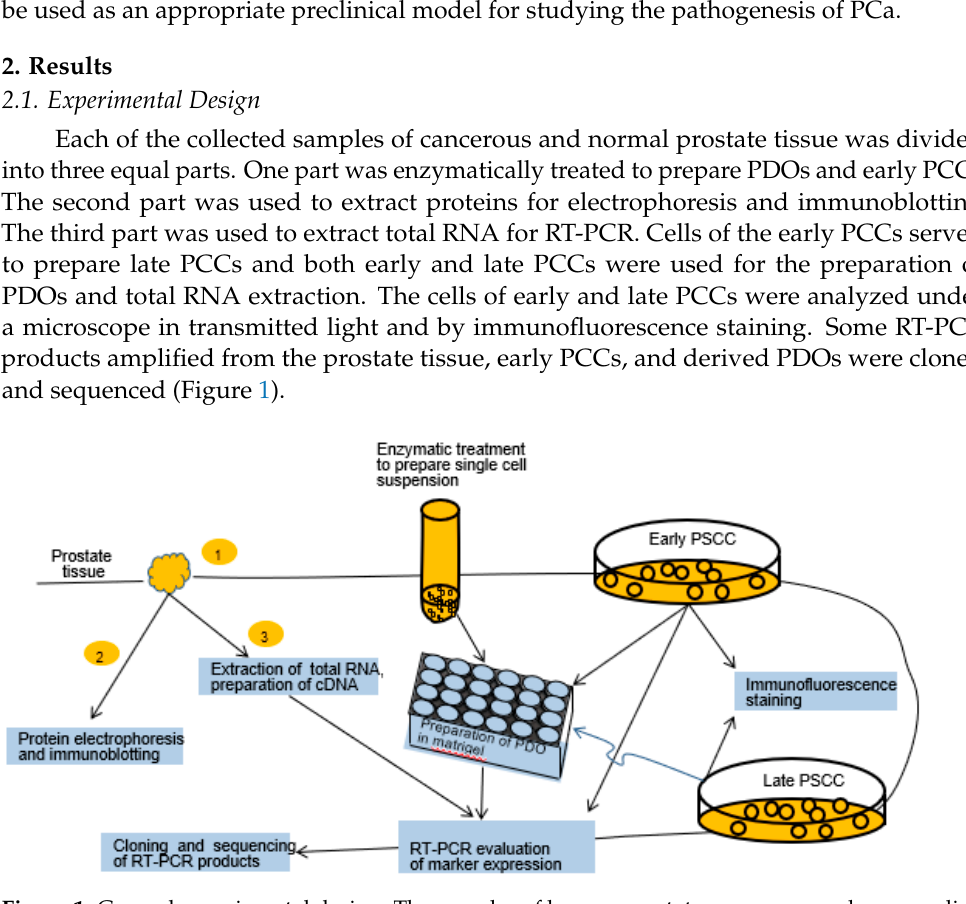
Figure 1. General experimental design. The samples of human prostate, cancerous and surrounding normal tissues, from PCa patients treated with radical prostatectomy were divided into three equal parts. One part was analyzed by Western blotting; the second part was used for the total RNA extraction and cDNA preparation for the analysis of cell markers by RT-PCR. The third part was enzymatically treated for the production of early and late cell cultures (PCCs) and PDOs. The cells of early and late PCCs were used for the microscopic analysis and immunofluorescence staining. The products of amplification of the TMPRSS2-ERG marker on prostate tissue, early PCCs, and derived PDOs were cloned and sequenced.